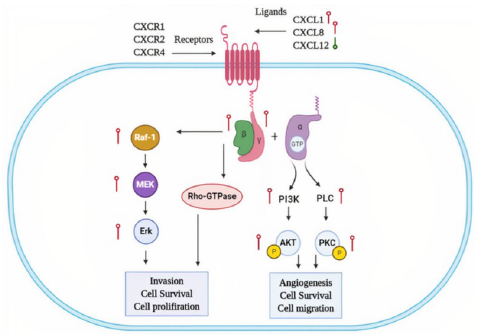
Fig 17. Crosstalk between the real hub genes involved pathways. At the cellular level, CXCL1, CXCL8 or CXCL12 binds to the GPCRs (CXCR1, CXCR2, or CXCR4) and activates the G protein. In this study, the up-regulation of GPCRs ligands (CXCL1 and CXCL8) and G protein subunits ( β and γ ) collectively are supposed to up-regulate the various downstream pathways. For example, the Heterotrimeric G α subunit up-regulation in this study further up- regulates its main effectors PLC and PI3K to induce hyper phosphorylation of PKC and Akt, respectively. The oncogenic roles of these two signaling pathways have already been reported to activate various respective transcription factors associated with angiogenesis, cell survival, and migration of tumor cells. On the other hand, β and γ G protein subunits up-regulation in this study further up-regulates the Rho-GTPase family and Raf-1/MAP/Erk signaling cascade which has been earlier reported to contribute in the cell invasion, cell survival, and cell proliferation